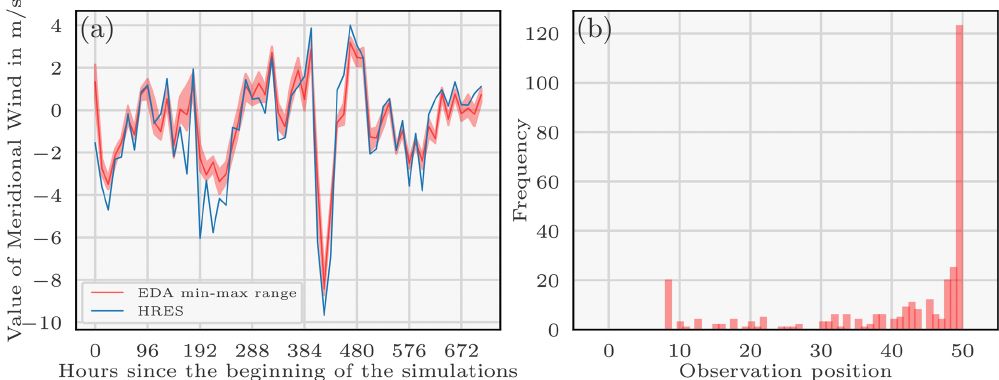
Figure 6. Evolution of the meridional wind of the HRES and EDA meteorologies for a random location in Europe since the beginning of the simulations. The red curve represents the mean of the meridional wind EDA members with the space between the minimum and maximum values (a) . Rank histogram: comparison between the 106 Ru observations and the reference predictions of the enhanced ensemble (b)